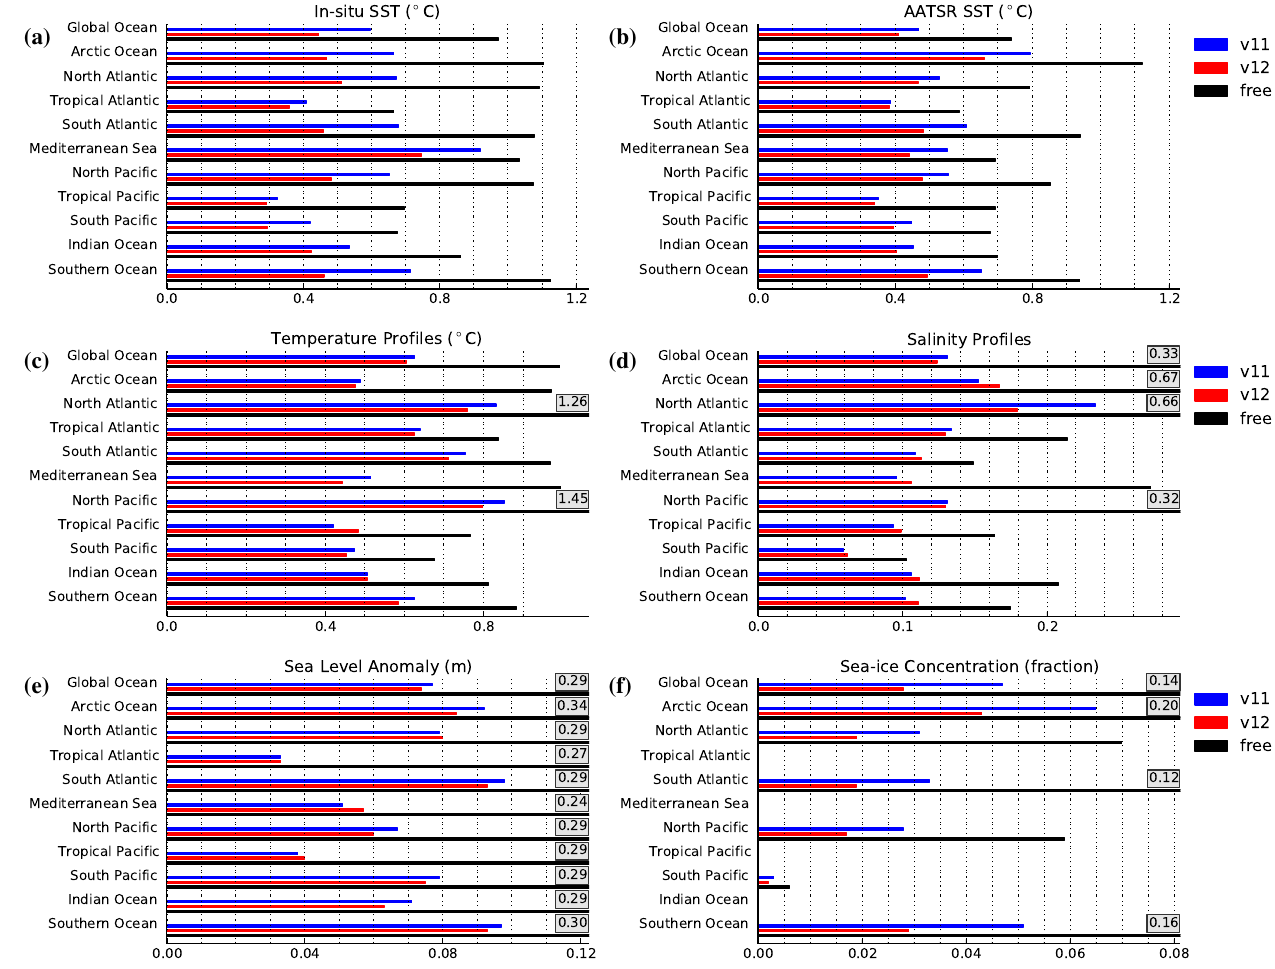
Figure 1. Root-mean-square (rms) errors against observations of (a) in situ surface temperature ( ◦ C), (b) AATSR satellite surface temperature ( ◦ C), (c) sub-surface temperature profiles ( ◦ C), (d) sub-surface salinity profiles (measured on the practical salinity scale), (e) sea level anomaly (m) and (f) sea ice concentration (fraction) for the v12 (red), v11 (blue) and free (black) trials. All statistics are compiled as averages over the full 2-year assessment period save for comparisons with AATSR data, which are only available until 8 April 2012. Where the rms errors for the free run are considerably higher than those for the assimilative runs, the x axis has been truncated in order to allow the reader to see the finer detail for the v12 and v11 runs. In these situations the rms value has been added as an annotation above the corresponding bar.